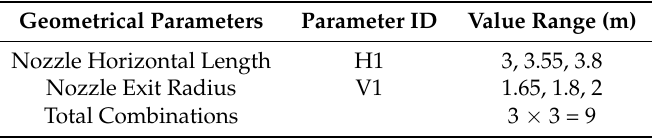
Table 3. Conical nozzle dimensional range.